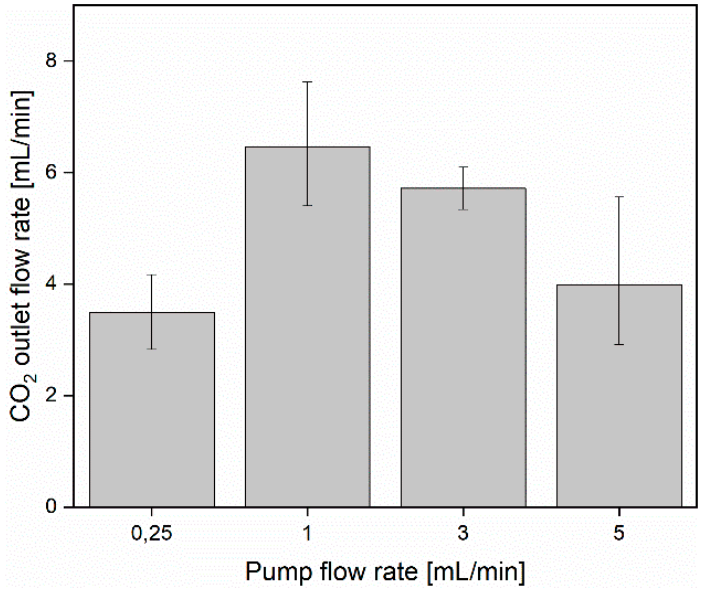
Figure 3. Average CO 2 flow for different pump flow rates (experimental conditions: Q inlet = 20 mL/min, J = 100 mA/cm 2 , CO 2 /N 2 ratio = 100%/0%).